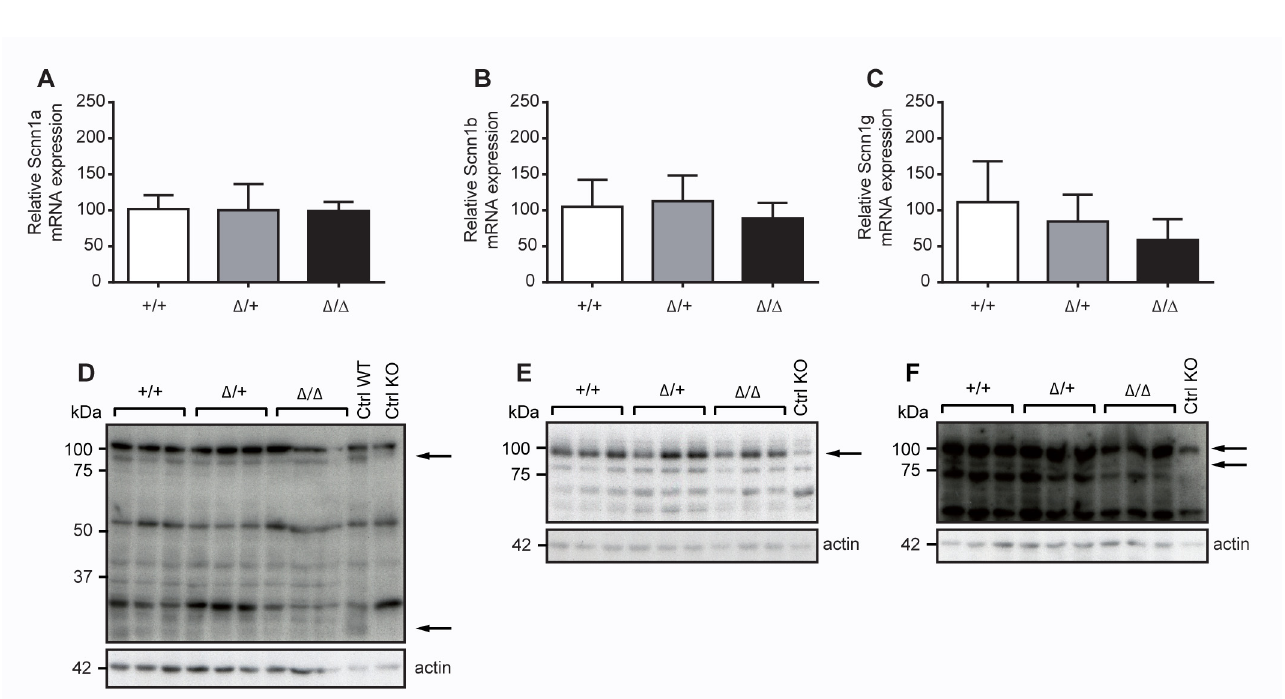
Fig 5. ENaC mRNA transcript and protein expression in kidneys from CAP2/ Tmprss4 wildtype (WT), heterozygous mutant (HET) and knockout (KO) mice under regular sodium diet. ( A-C ) Relative mRNA transcript and ( D-F ) ENaC and β -actin protein expression in kidneys of ( A ) Scnn1a in CAP2/ Tmprss4 wildtype (WT, n = 6), heterozygous mutant (HET, n = 7) and knockout (KO, n = 5) mice, ( B ) Scnn1b in CAP2/ Tmprss4 wildtype (WT, n = 6), heterozygous mutant (HET, n = 7) and knockout (KO, n = 5) mice, and ( C) Scnn1g in CAP2/ Tmprss4 wildtype (WT, n = 6), heterozygous mutant (HET, n = 5) and knockout (KO, n = 5) mice; β -actin was used as internal control. Representative immunoblots of ( D) Scnn1a, ( E ) Scnn1b and ( F ) Scnn1g and its corresponding β -actin protein expression in CAP2/ Tmprss4 wildtype (WT), heterozygous mutant (HET) and knockout (KO) mice; kidney extracts from Scnn1 wildtype (WT) and knockout (KO) mice were used as positive and negative control respectively; arrows indicate the full-length and the corresponding cleaved ENaC fragments.